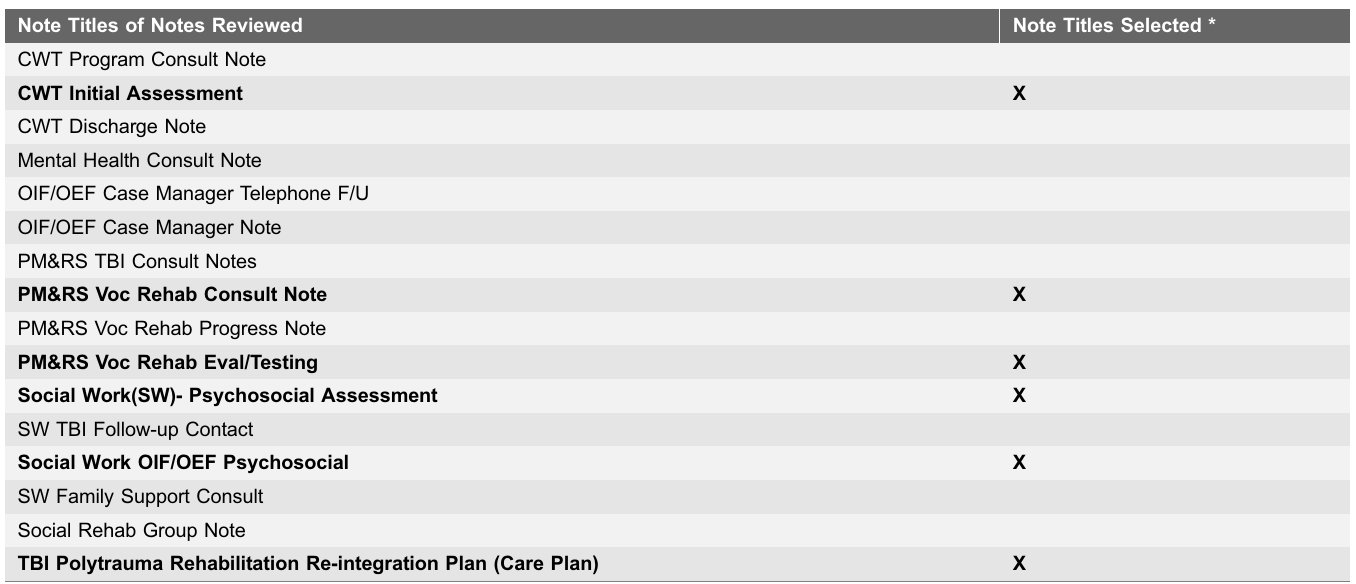
Table 1. Note Titles Reviewed and